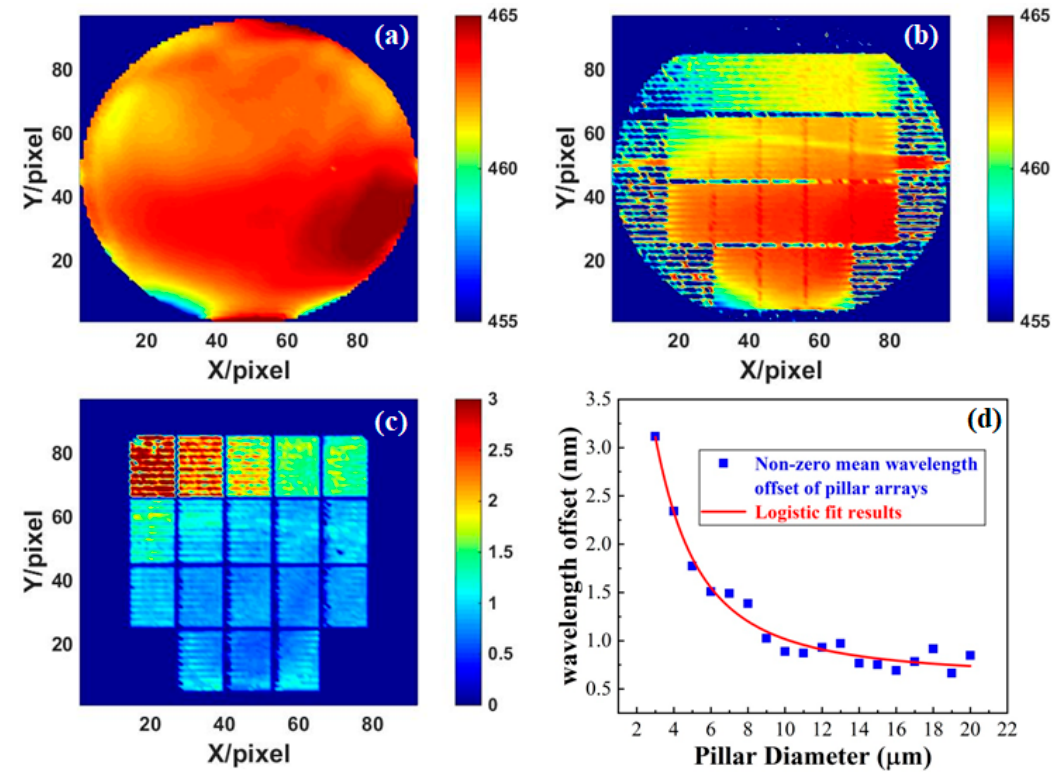
Figure 3. Features of PL spectral data: ( a ) PL spectrum of the GaN blue LED epitaxial wafer before etching, denoted as ORI; ( b ) PL spectrum of the epitaxial wafer after micro-pillar etching, denoted as AFT; ( c ) micro-pillar arrays’ wavelength shift, ORI-AFT wavelength shift; ( d ) average wavelength shift for different pillar sizes.